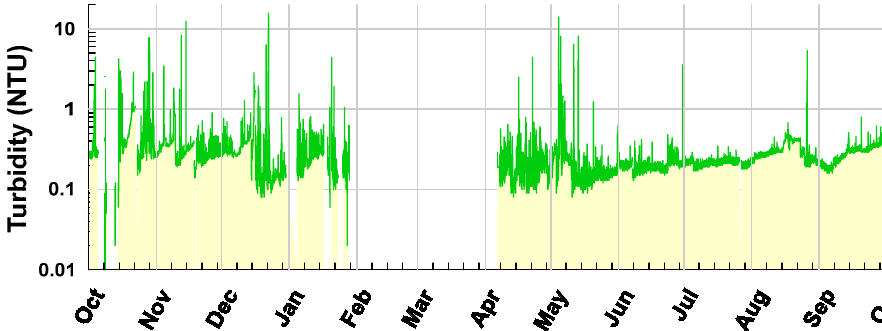
Figure 8. Time evolution of turbidity 2020/2021.